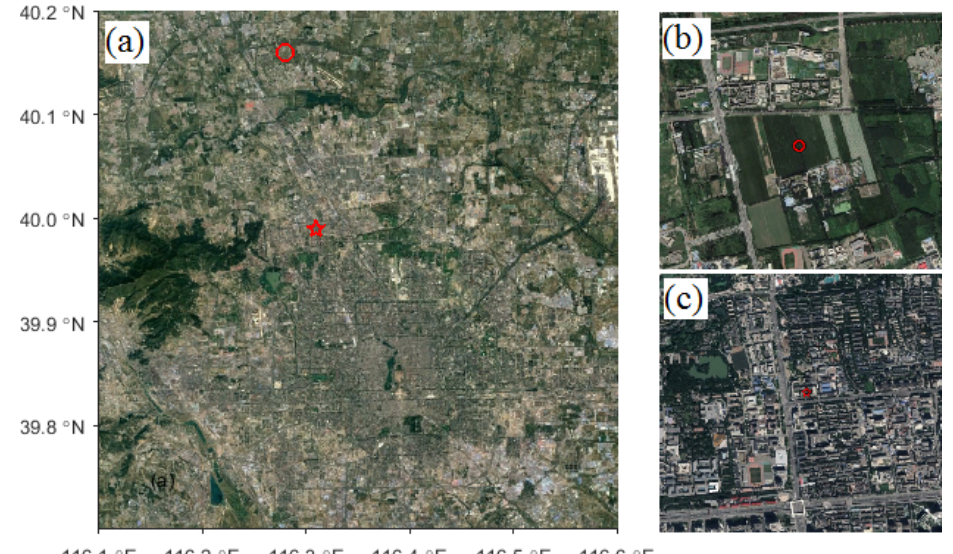
Figure 1. Google Earth map of the observation sites in Beijing: (a) the observation site located in the urban underlying surface region (marked by the red pentagram) and the observation site located in the suburban underlying surface region with a flat terrain (marked by the red circle). The corresponding terrains (within a range of approximately 1km) around the observation sites are shown in (b) and (c)